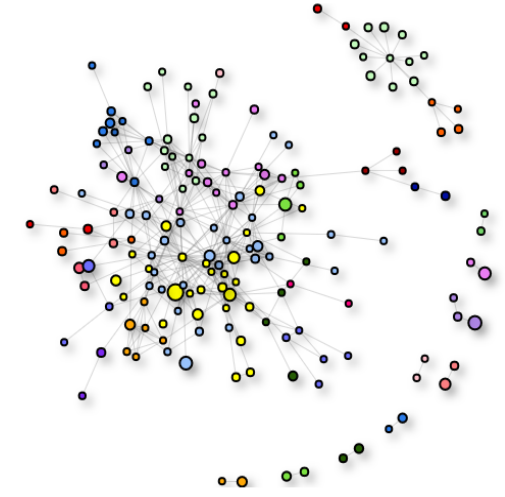
Figure 1. Social Network